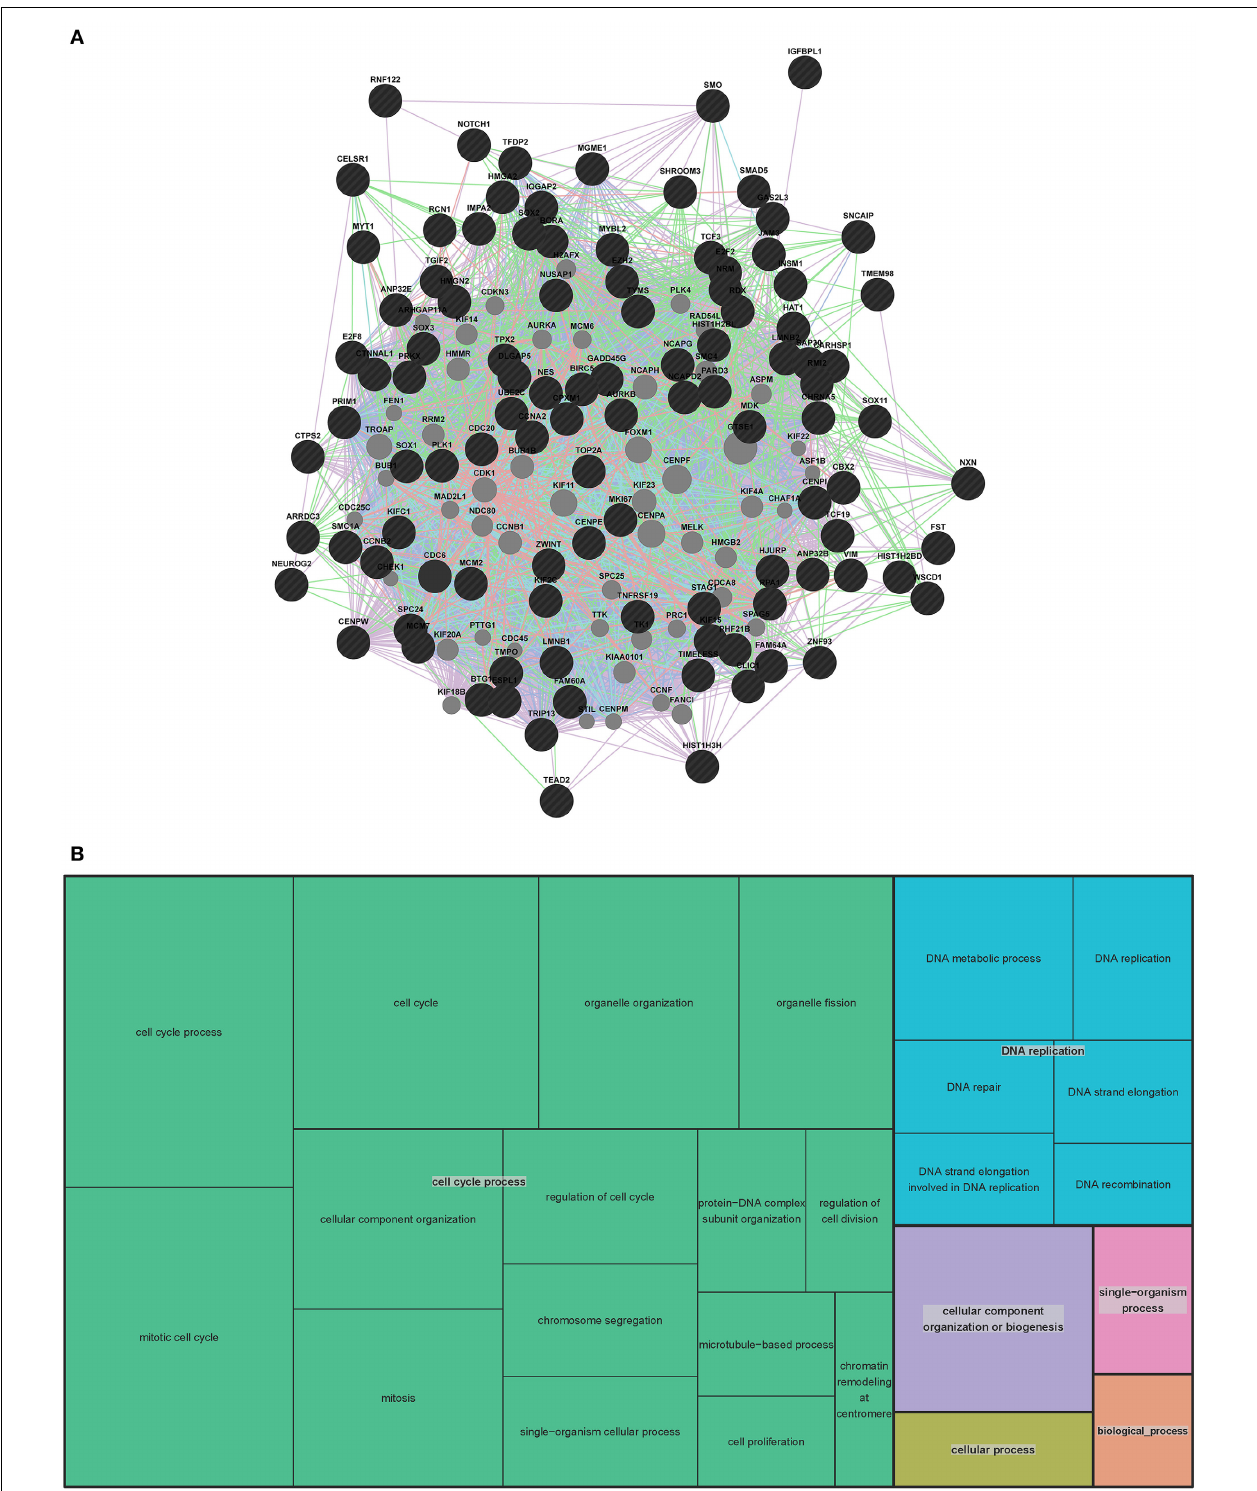
FIGURE 5 | Human extended association analysis network and Gene Ontology (GO) analysis of human network genes. (A) The top 100 genes from the human network and the 7 genes that overlap between the human and mouse network were used to search for associations between those genes and to find additional genes that associate with them. 50 associated